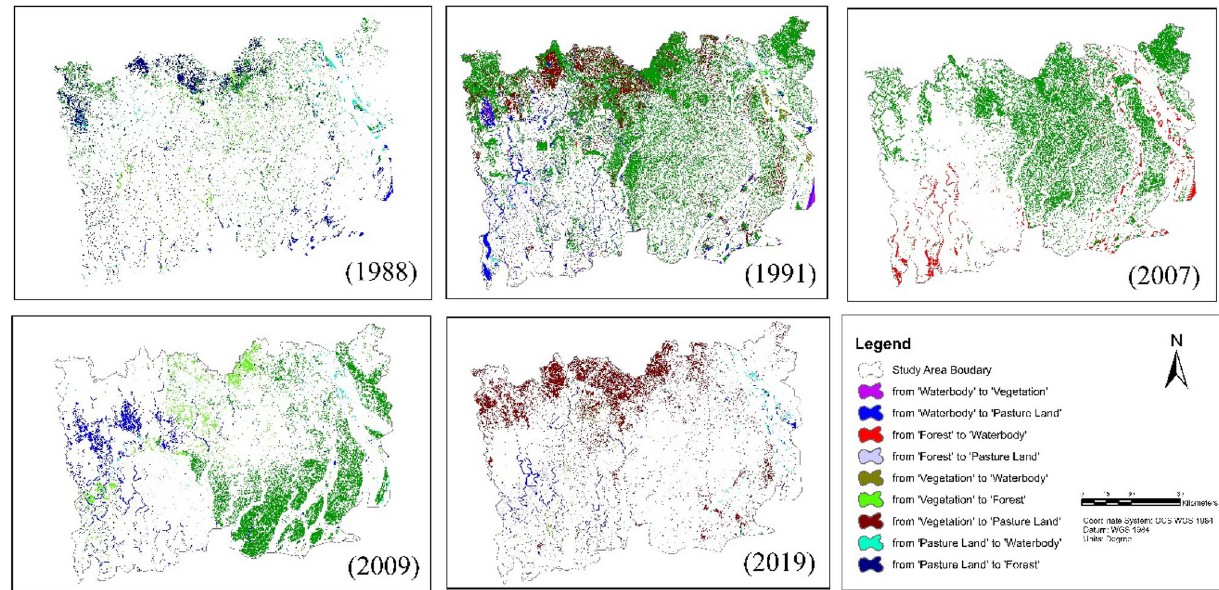
Fig. 9 Thematic change dynamics of 1988, 1991, 2007, 2009,